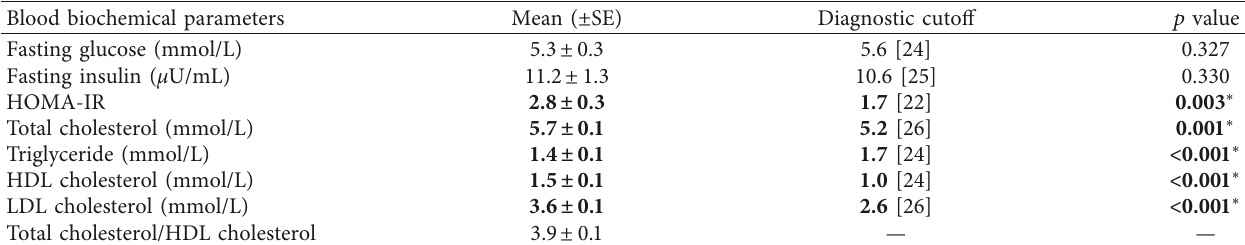
Table 5: Differences between blood biochemical parameters and respective diagnostic cutoffs in obese individuals carrying ADRB2 rs1042713G